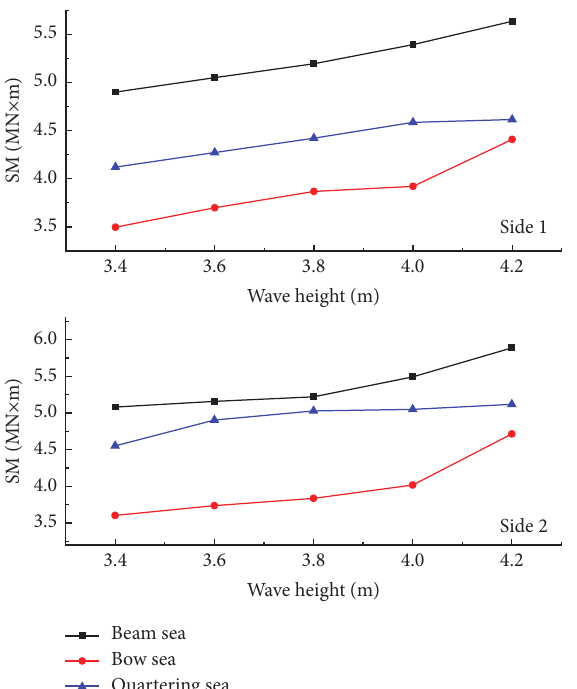
Figure 35: TTM time histories in beam sea.